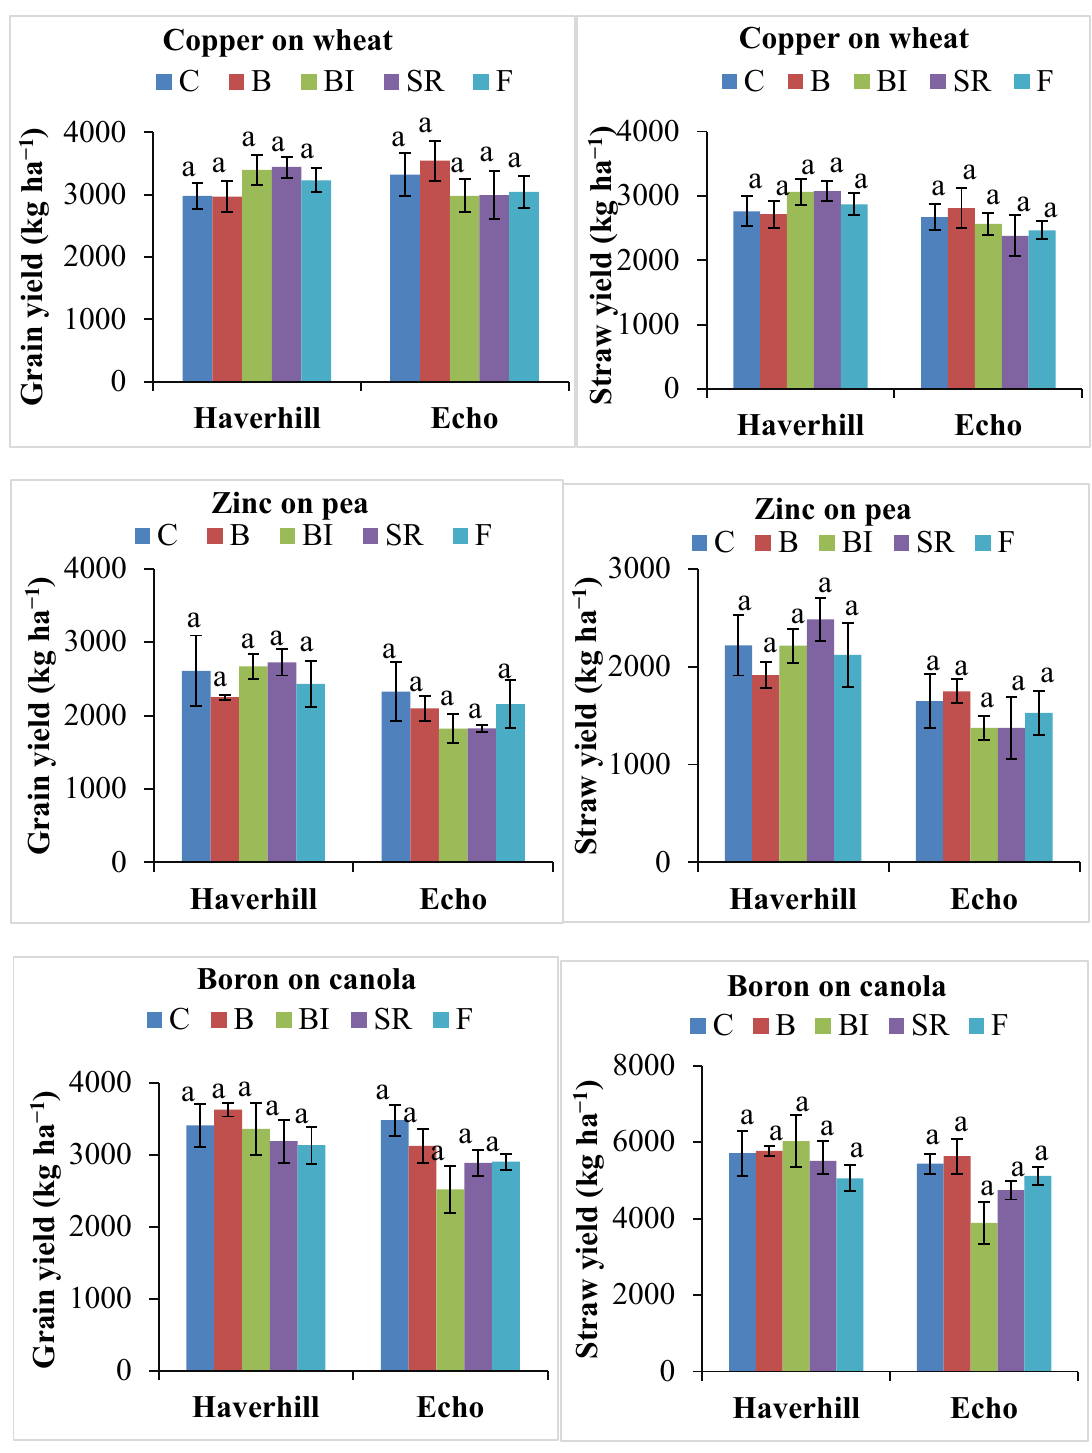
Figure 1. Effect of different placement methods of Cu, Zn, and B fertilizers on biomass yield of wheat, pea and canola, respectively at Central Butte field location in 2015. Crops were grown at two sites in the field representing two different landscape elevation positions classified as Haverhill (upslope) and Echo (downslope) soil associations, respectively. Treatment evaluation includes C: control; B: broadcast; BI: broadcast and incorporation; SR: seed row banding; and F: foliar methods of fertilizer application. Treatment columns for a site followed by the same letter are not significantly different ( p > 0.05). Error bar represents standard error of mean.